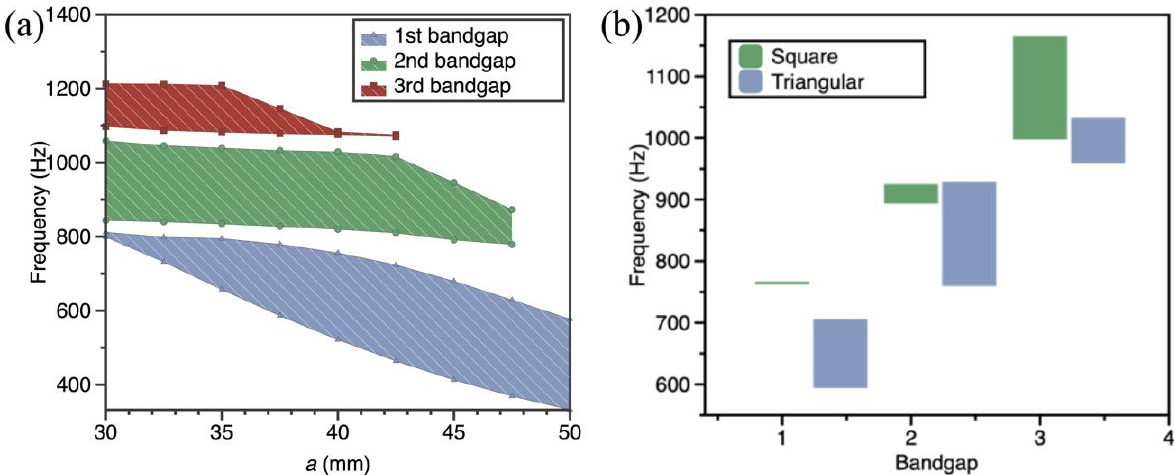
Figure 11. Effect of period parameters on bandgap of the SPLCRR. ( a ) period length ( b ) different distribution forms.